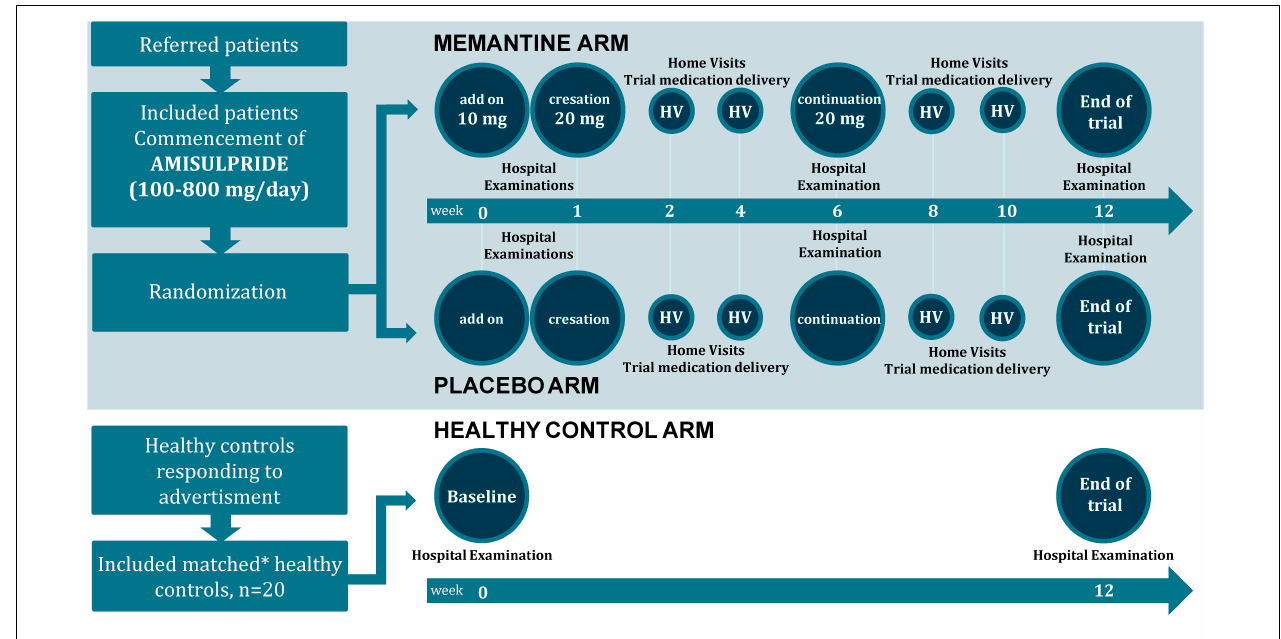
FIGURE 1 | AMEND flow